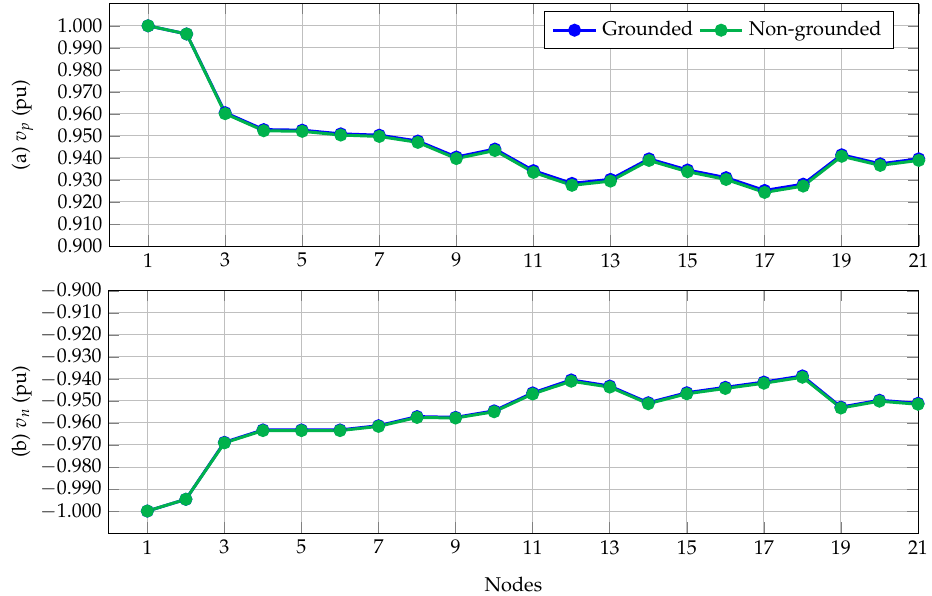
Figure 5. Behavior of the voltage profiles for the meshed configuration of the 21-bus system with the grounded and non-grounded connections of the neutral